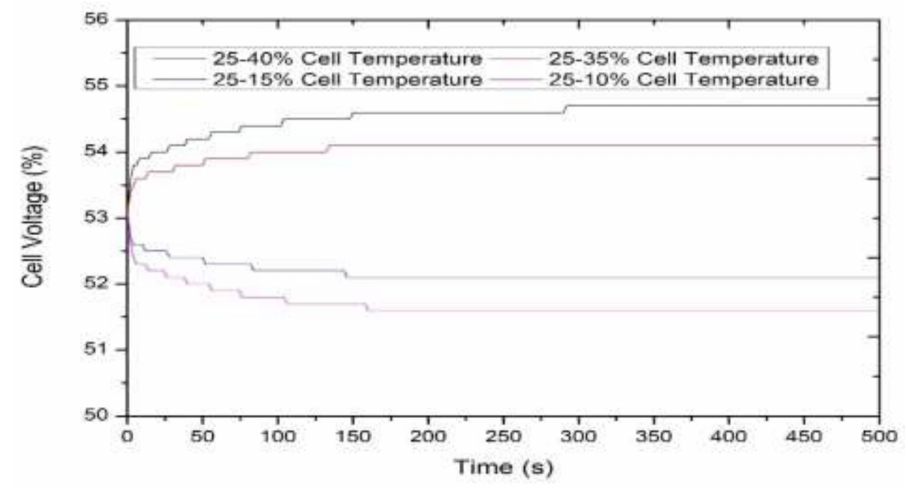
Figure 6. Step response of DMFC at 25% ofthe operating temperature.